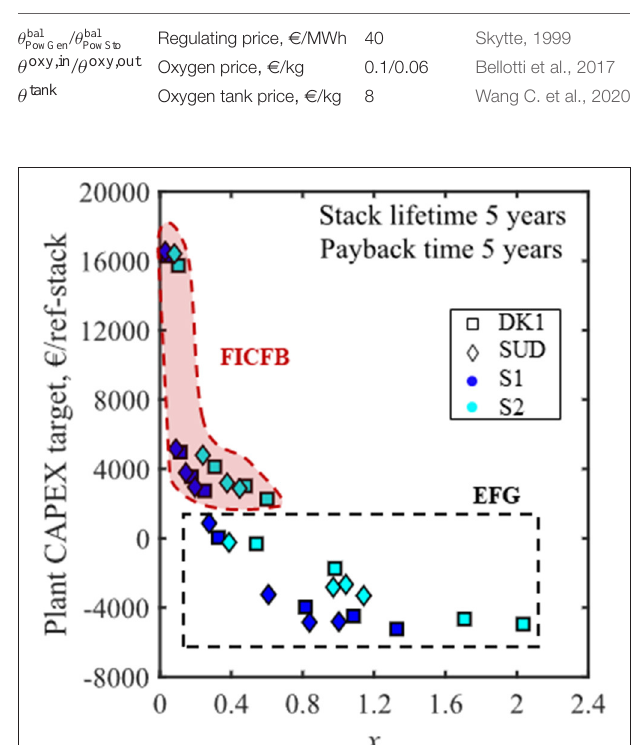
FIGURE 6 | Plant CAPEX target of the case studies with different plant technologies, geographical zones, and flexibility-need scenarios. Note the profit from methane sale is not considered in this figure. The reference stack is defined as a stack with a total active cell area of 5,120 cm 2